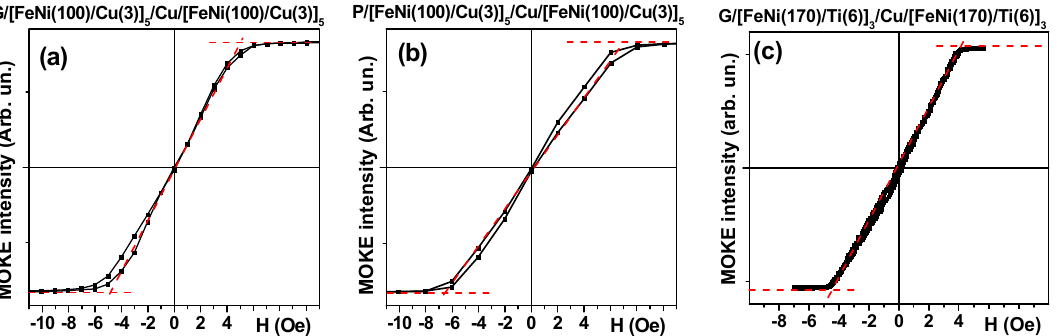
Figure 7. M(H) hysteresis loops of MI multilayered structures in the shape of rectangular elements. Numbers indicate thicknesses of the layers in nanometers. Thickness of the central Cu lead was equal to 500 nm in all cases under consideration. MI multilayers in the cases ( a , c ) were deposited onto glass substrates and onto cycloolefin COC flexible substrate in case ( b ). All units for the thickness of the layers are nanometers. The dashed red lines determine the anisotropy fields.